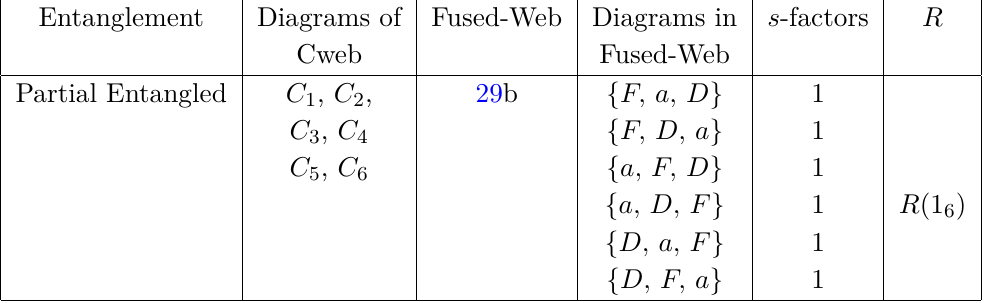
Table 18. Fused-Webs and their mixing matrices for Cweb W (4)